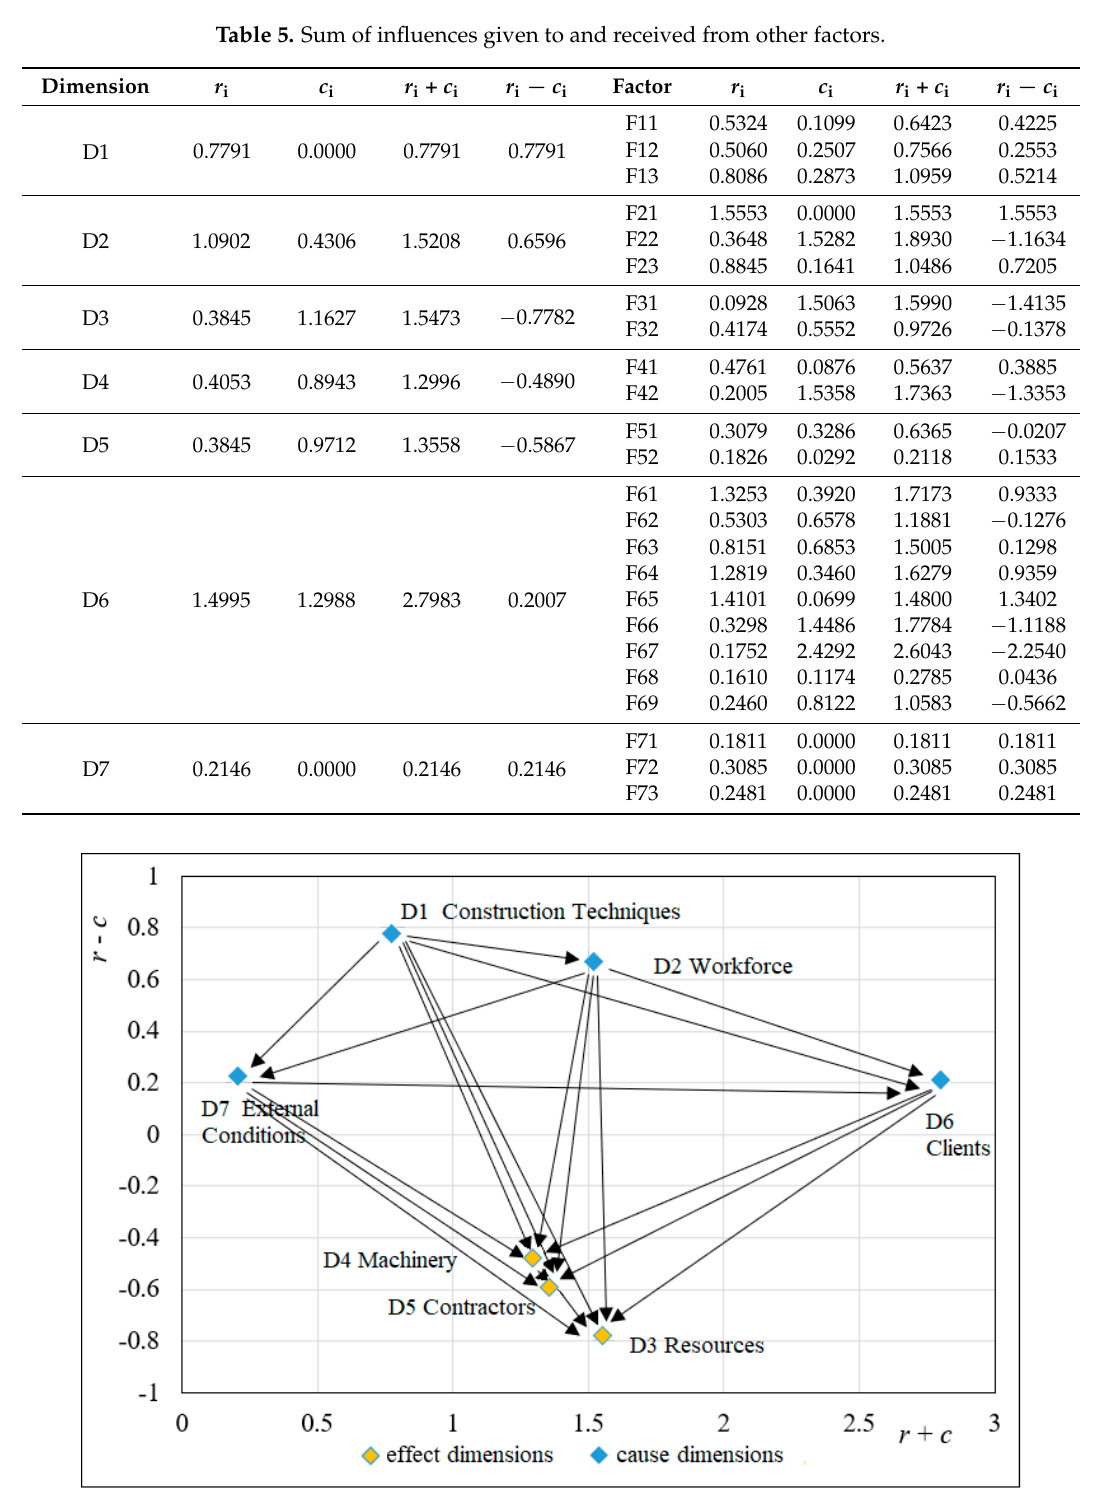
Table 5. Sum of influences given to and received from other factors.